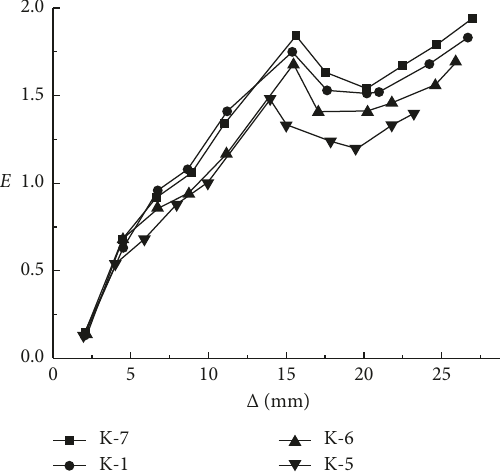
Figure 12: Skeleton curves of frames with various reinforcement ratios.